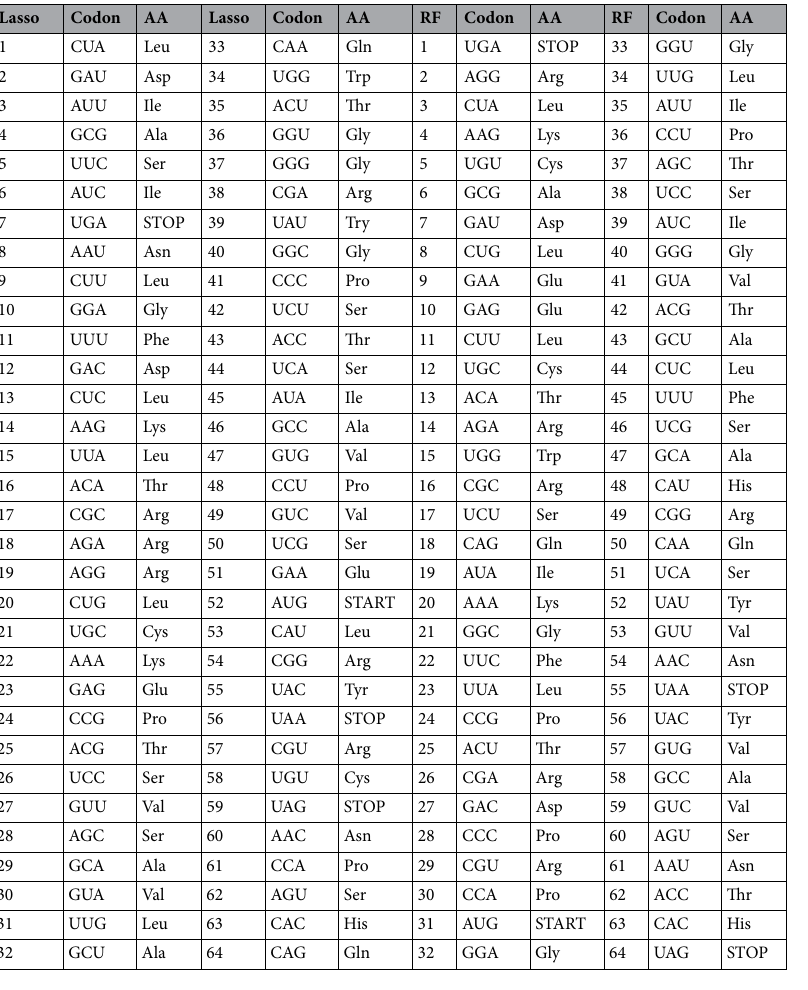
Table 3. Sorting codon usage frequencies and their corresponding amino acid by their kingdom prediction power with lasso and RF. The left side ranks the codons and their corresponding amino acids (AA) by our lasso feature ranking system. The right side is the same but with our RF feature ranking system. Codon usage frequency as a feature is tested by its influence on predicting phylogeny in our kingdom discrimination: viral, phageal, bacterial, archaeal, and eukaryotic. Lasso directly compares the dropout of each feature to the R the fitted model, while RF does this indirectly. Therefore, these represent the features that roughly account for the most variance in phylogenetic prediction. While the systems differ in their exact order, there are many commonalities in the relative order of the codons. For instance, UGA being more influential than UAA in both